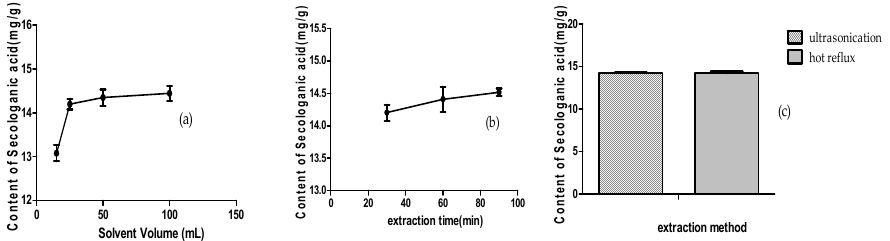
Figure 5. The content of secologanic acid in LJF under different extraction conditions: ( a ) solvent volume, ( b ) extraction time, ( c ) and extraction method.